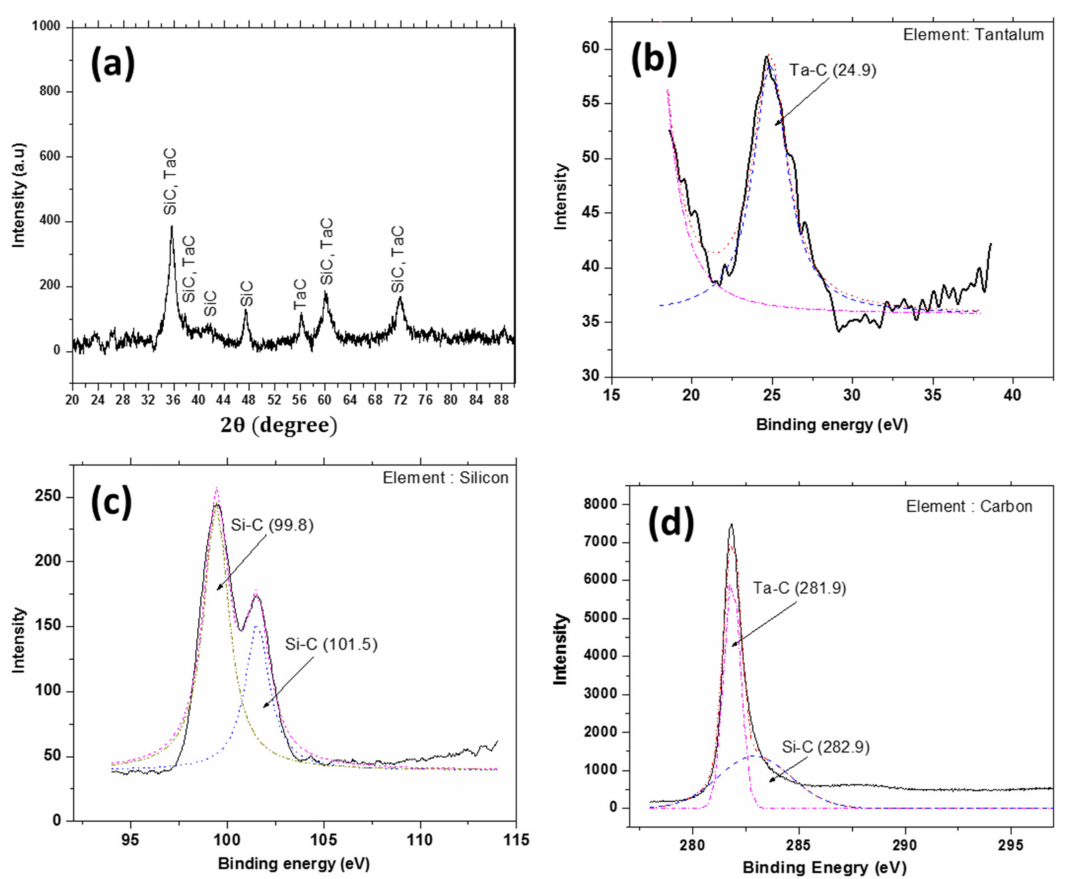
Figure 4. XRD and XPS analysis of as-deposited coating: ( a ) XRD spectra after the deposition of four layers; ( b ) XPS spectra of TaC binding energy; ( c ) XPS spectra of SiC binding energy; ( d ) XPS spectra